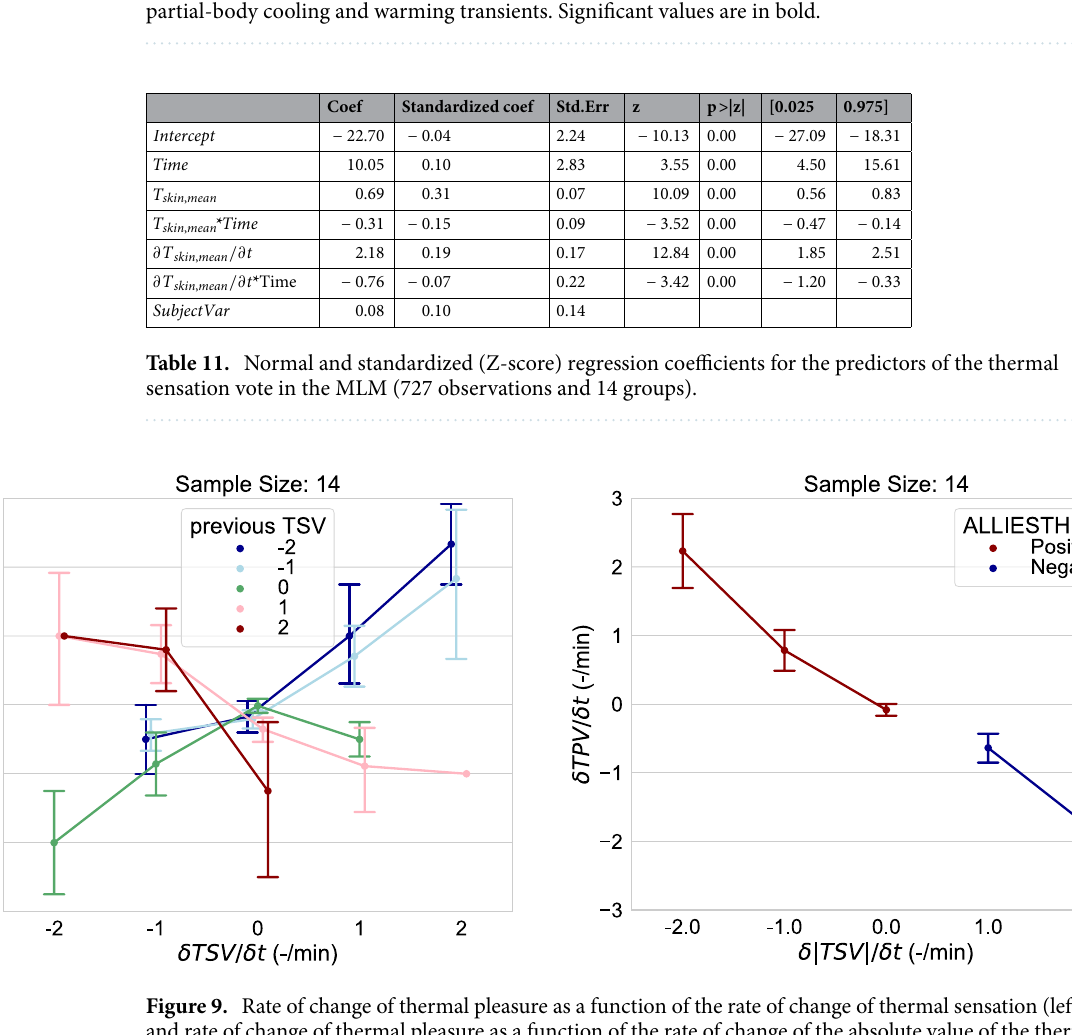
Table 10. Sex differences in thermal sensation vote and its relative change over the course of the last two partial-body cooling and warming transients. Significant values are in bold.